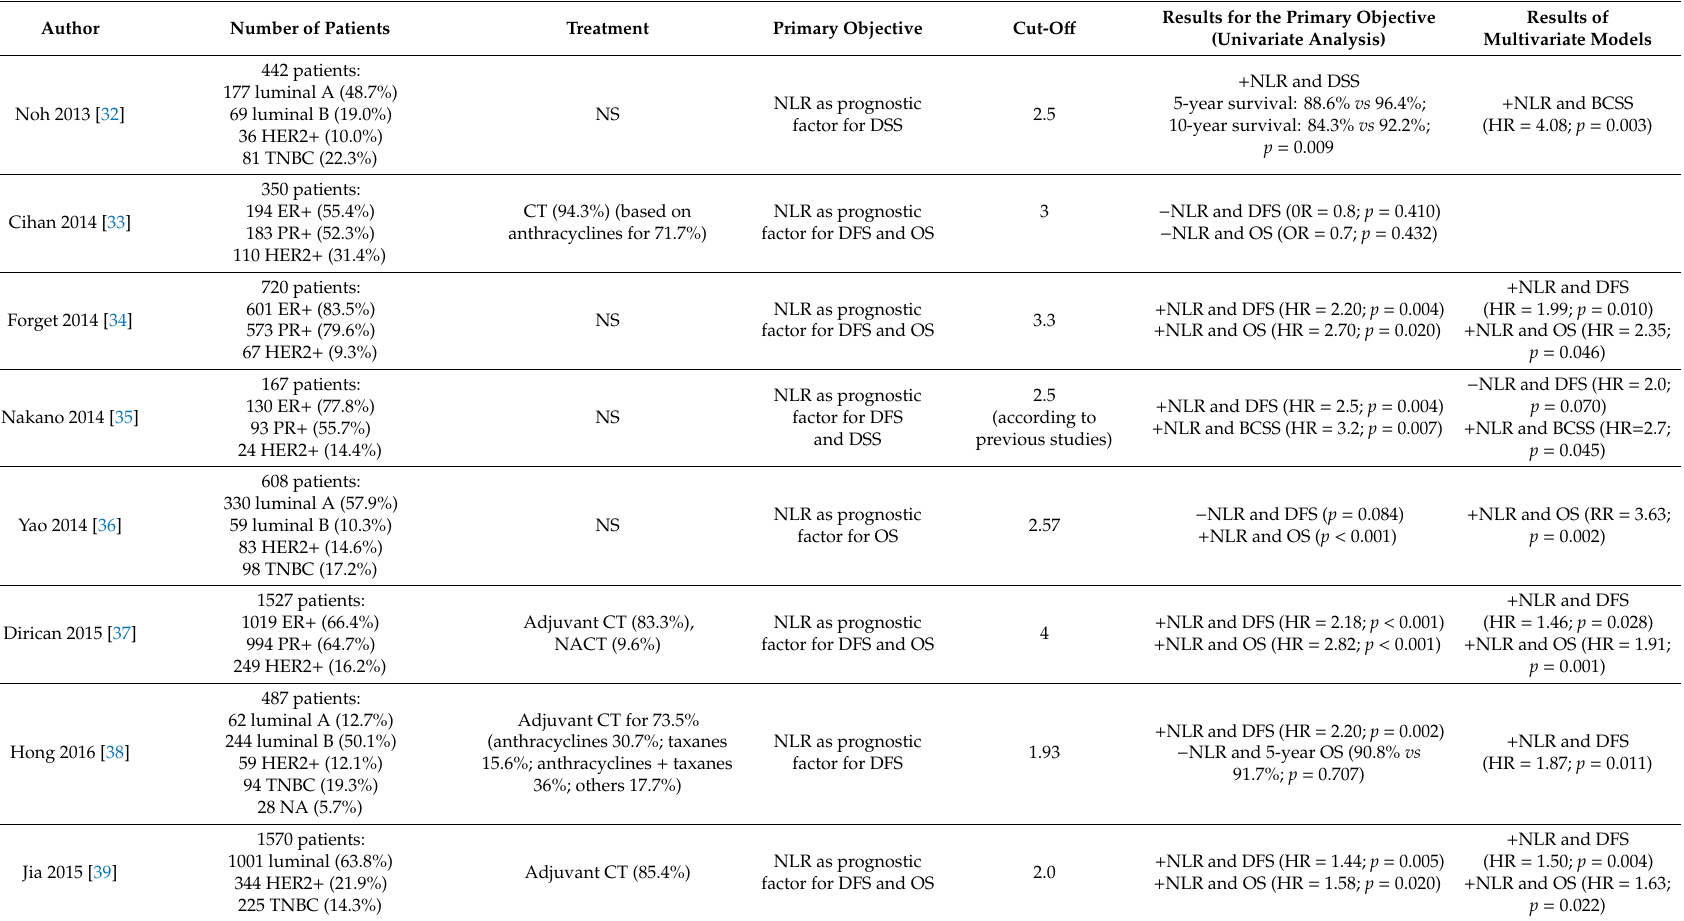
Table 3. Articles including data on NLR as prognosis factor in patients with localized BC receiving adjuvant